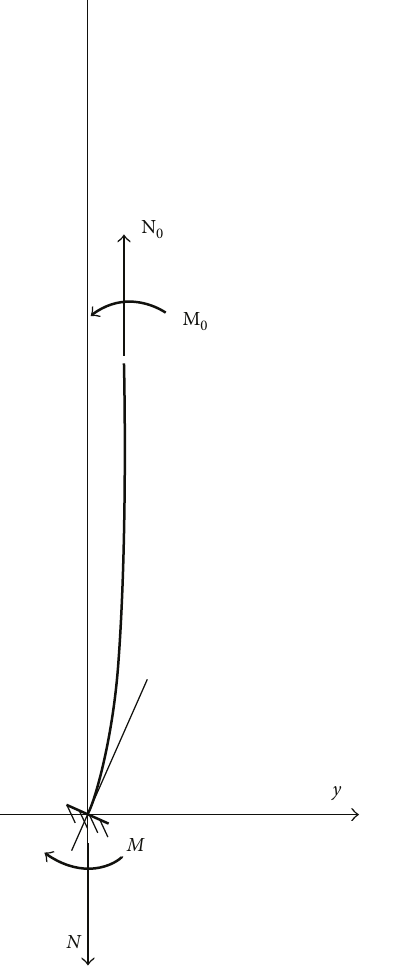
Figure 9: Model of the suspension cable as a bending